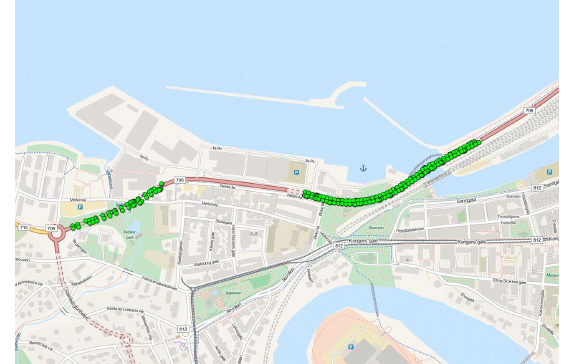
Figure 2: Trajectory and positions of the reference solution mea- surements (green circles) inside Ilsvik and Skansen tunnels, ob- tained by using total station equipment. Data collection performed by Nidaros oppmåling AS.